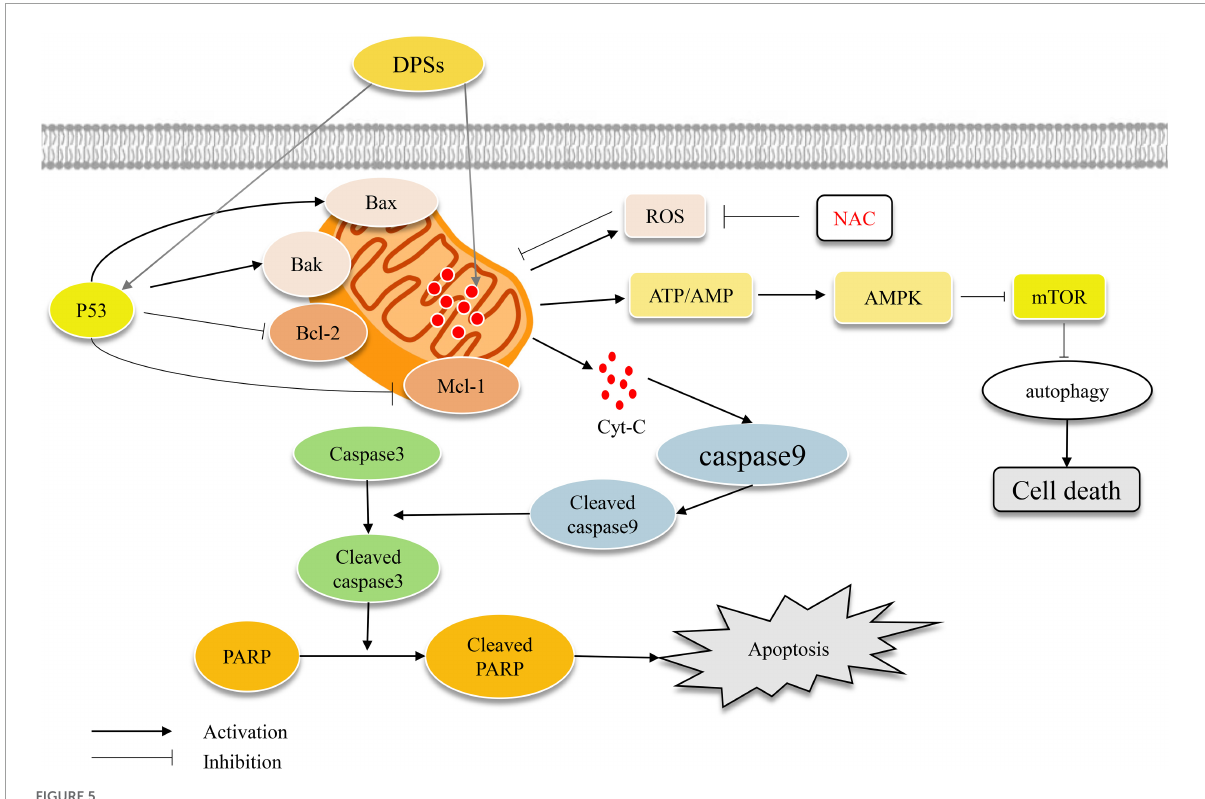
FIGURE5 The potential anti-tumor mechanisms of D. officinale